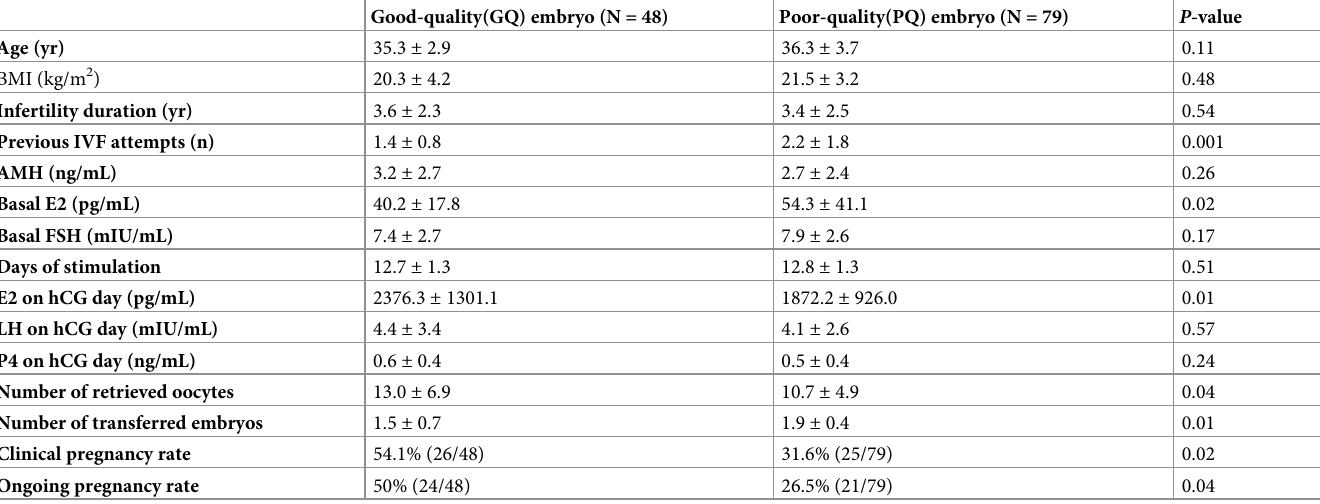
Table 1. Patient characteristics for the analysis of granulosa cell gene expression associated with embryo